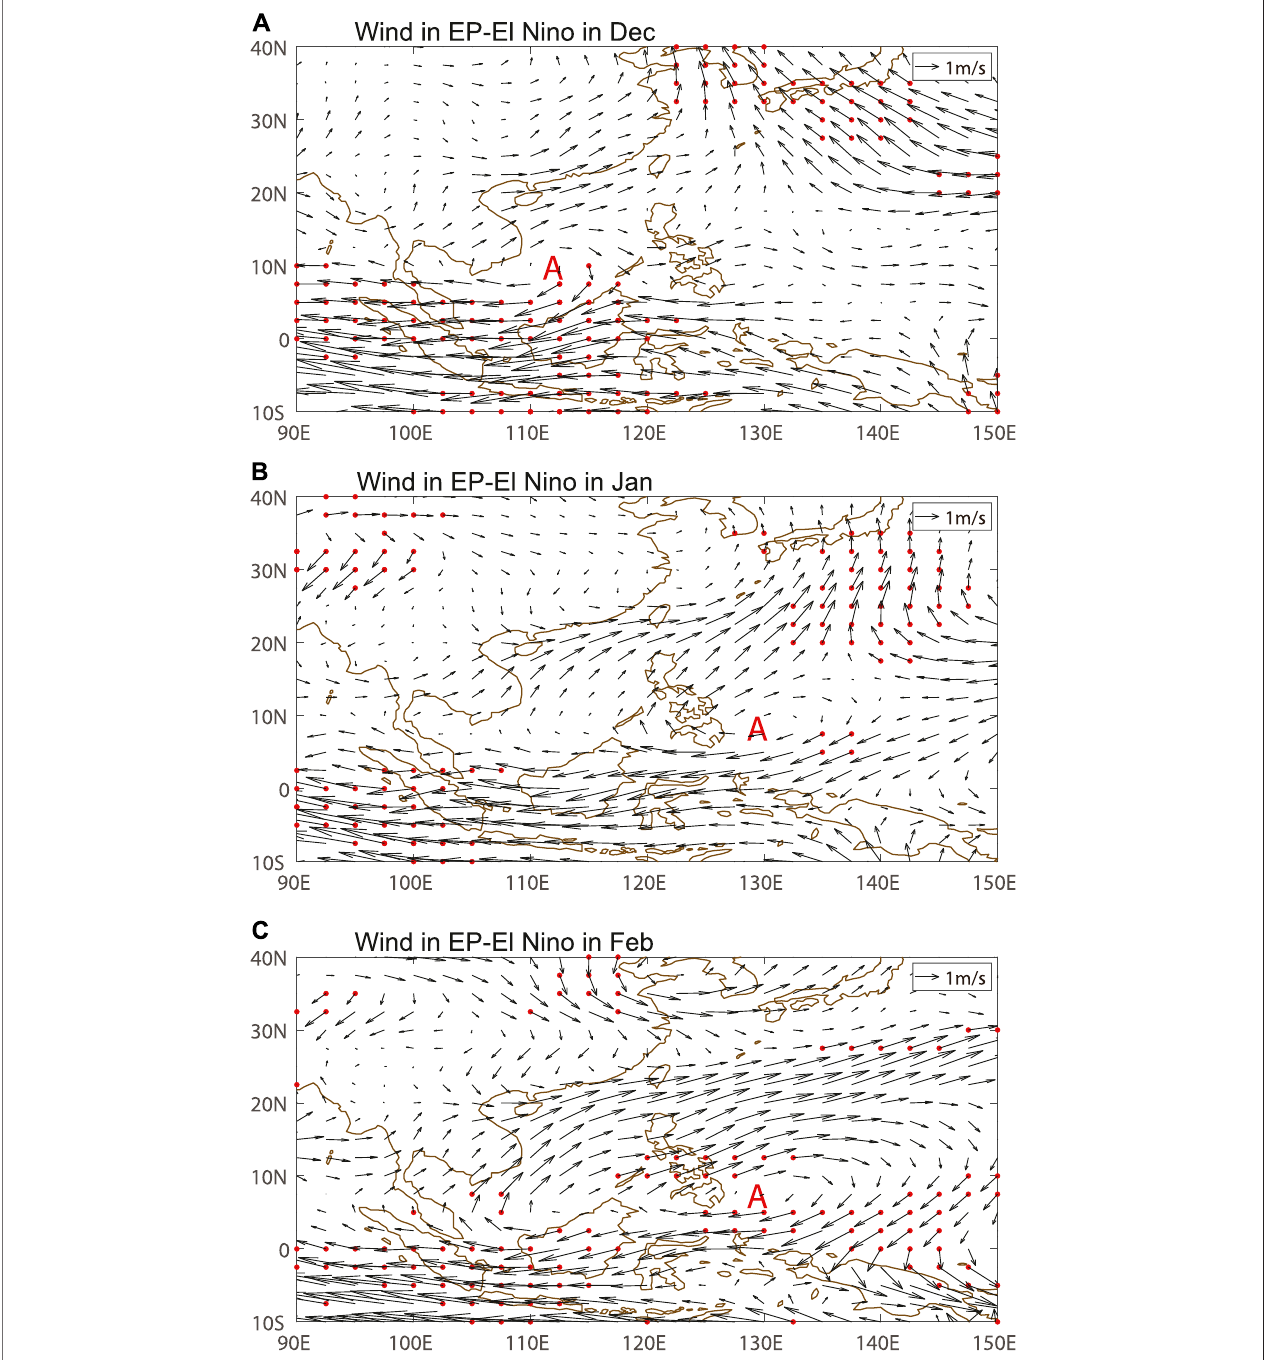
FIGURE 5 | 850 hPa wind anomalies (units: m s − 1 ) during El Niño mature phases in (A) December, (B) January, and (C) February. Dotted areas indicate the 0.05 signi fi cance level. “ A ” indicates the center of an anticyclone.